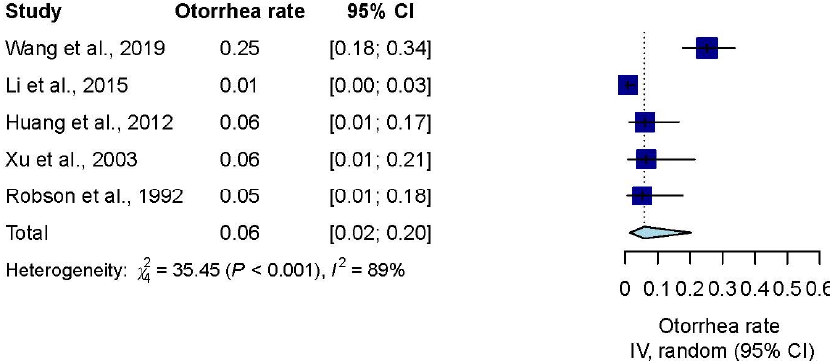
Figure 4. Effect estimate of post-VTI otorrhea rate.